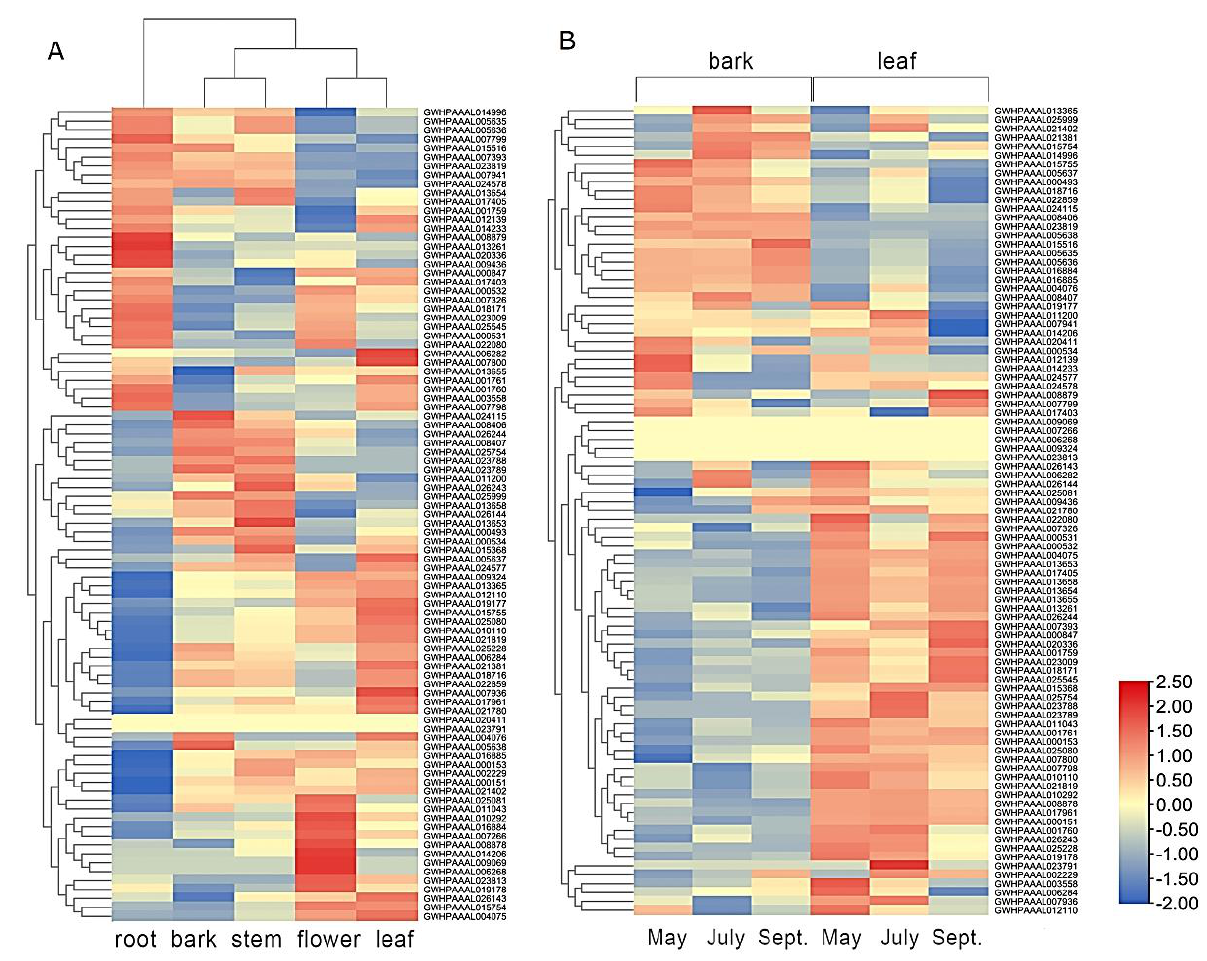
Figure 6. The transcriptome analysis of Eu UGT genes. ( A ) Heatmap of Eu UGT gene transcription in various organs. ( B ) Heatmap of Eu UGT gene transcription over various seasons. The TPM value of each Eu UGT gene was calculated by Stringtie and normalized with RowScale method by TBtools, and then used to construct the heatmap. In each row, red color represents higher expression level, blue color shows lower expression.